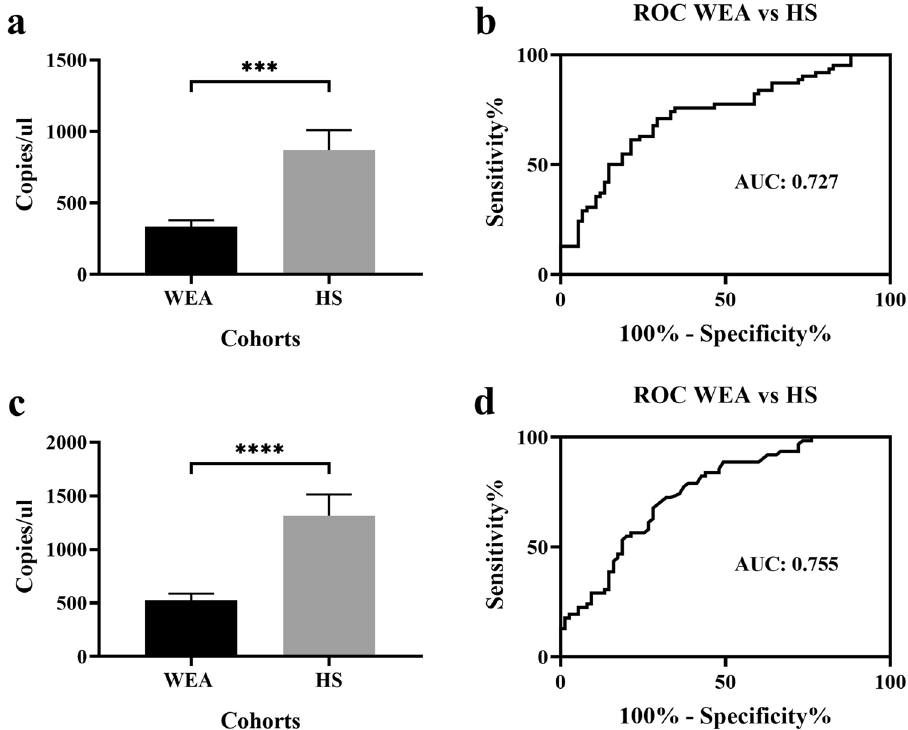
Figure 1. The miR-197-3p quantification. ( a ) miR-197-3p quantification in sera from WEA and HS cohorts using RT-qPCR. ( b ) ROC curve to quantify RT-qPCR accuracy. ( c ) miR-197-3p quantification in sera from WEA and HS cohorts using dd-PCR. ( d ) ROC curve to quantify dd-PCR accuracy.